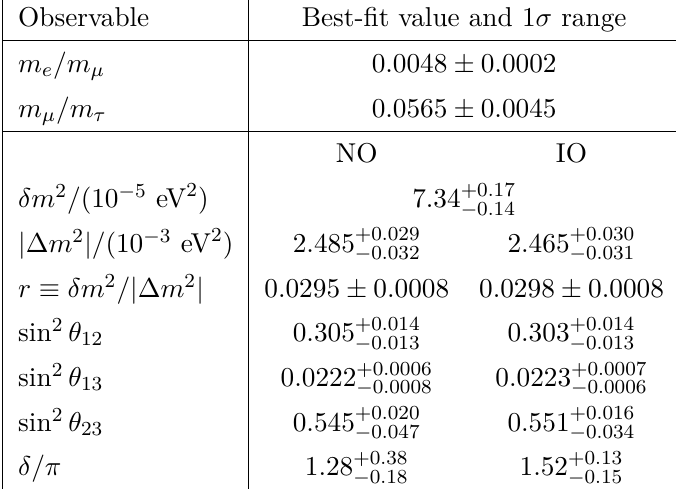
Table 3. Best-fit values and 1 σ ranges for neutrino oscillation parameters obtained from the global analysis [115], and for charged-lepton mass ratios, given at the scale 2 × 10 16 GeV with the tan β averaging described in [12], obtained from ref. [116]. The parameters entering the definition of